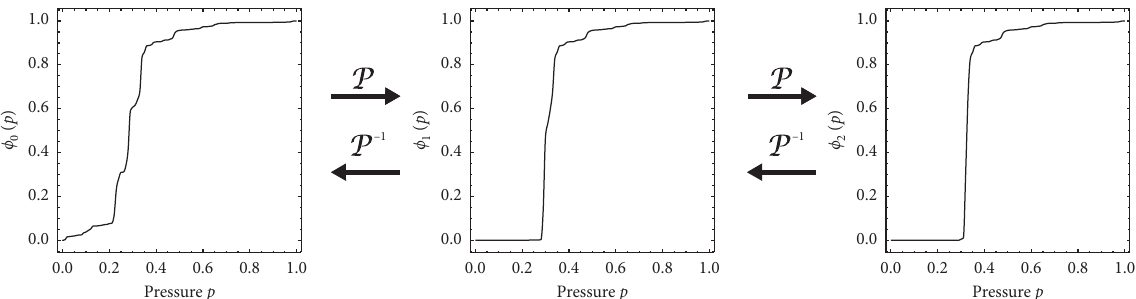
Figure 7: The unknown ϕ